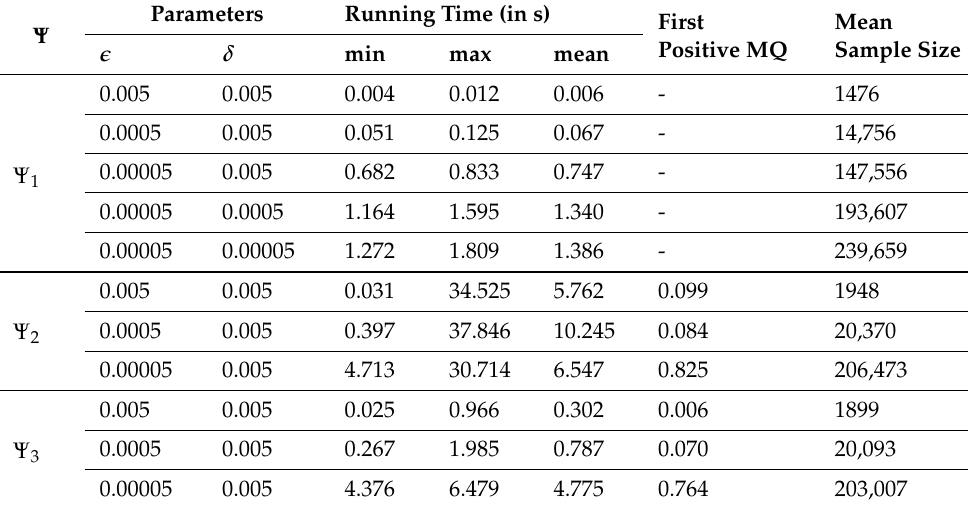
Table 2. Dyck 1: On-the-fly verification of RNN.